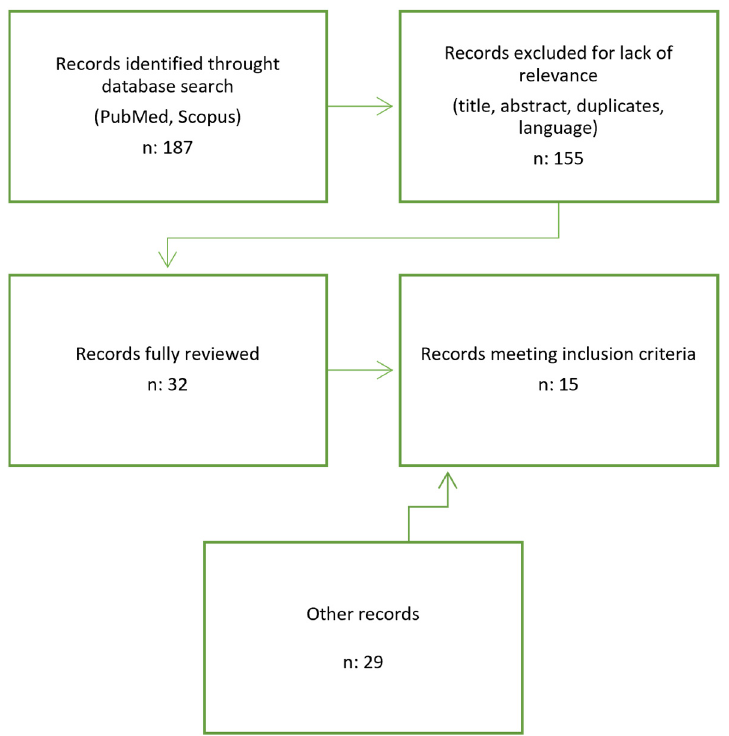
Figure 1. Diagram resembling Electronic Database Search and Inclusion/Exclusion process of the review. Year filter: January 2017 to November 2022. review. Year filter: January 2017 to November